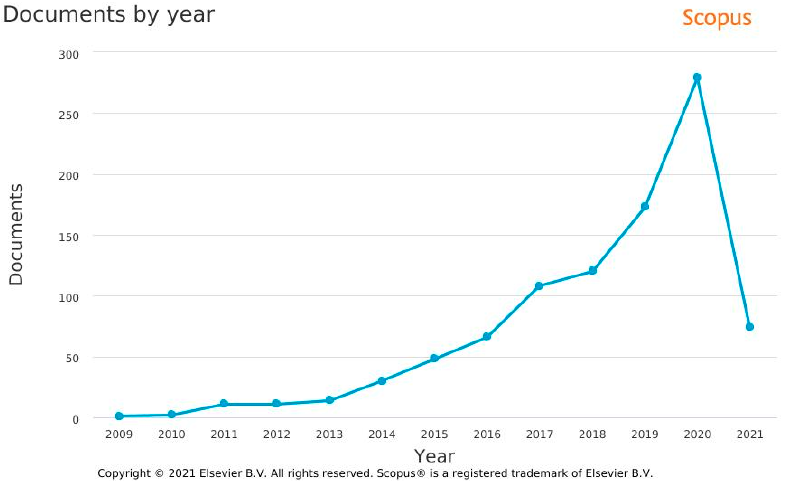
Figure 2. Publications on translanguaging by year (https://www.scopus.com/home.uri, accessed on 12 February 2021).